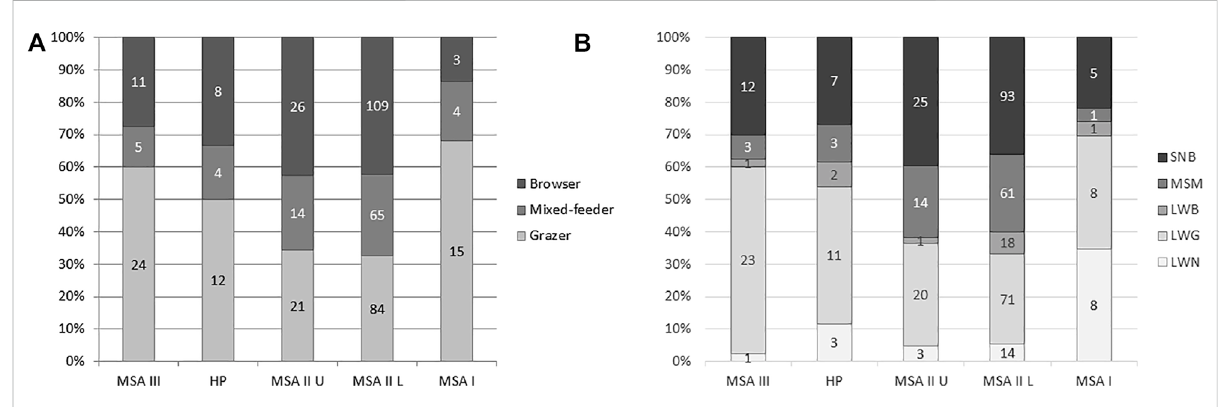
FIGURE 2 (A) Ungulate dietary preference proportions at Klasies River. (B) Herbivore functional type proportions based on Hempson et al. (2015). SNB = small non-social browser, MSM = medium-sized social mixed-diets, LWB = large water dependent browsers, LWG = large-medium water dependent grazers, LWN = large water dependent non-ruminants. Number of specimens in columns.